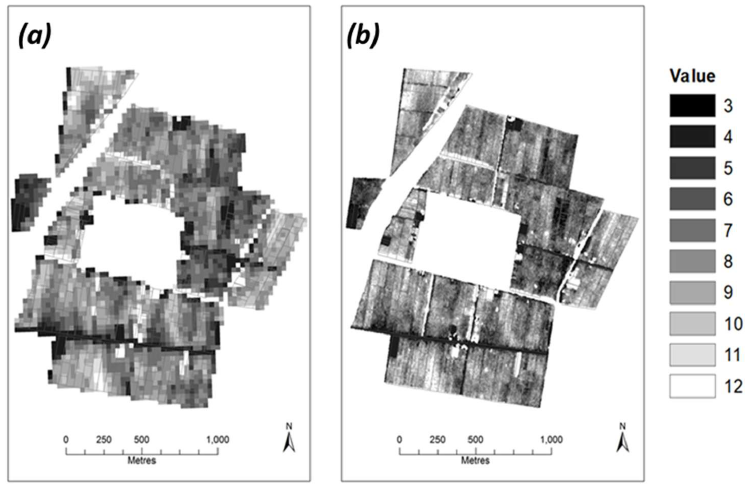
Figure 5. Soil brightness image ( a ) for 2017 resampled to match the LandSat8 spatial resolution (30 m) and ( b ) the original soil brightness image (3 m resolution).